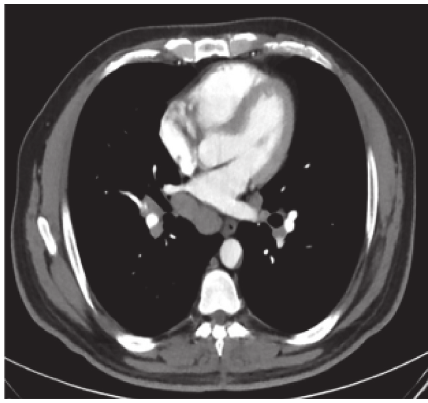
Figure 5: CT chest showing bilateral mediastinal and hilar